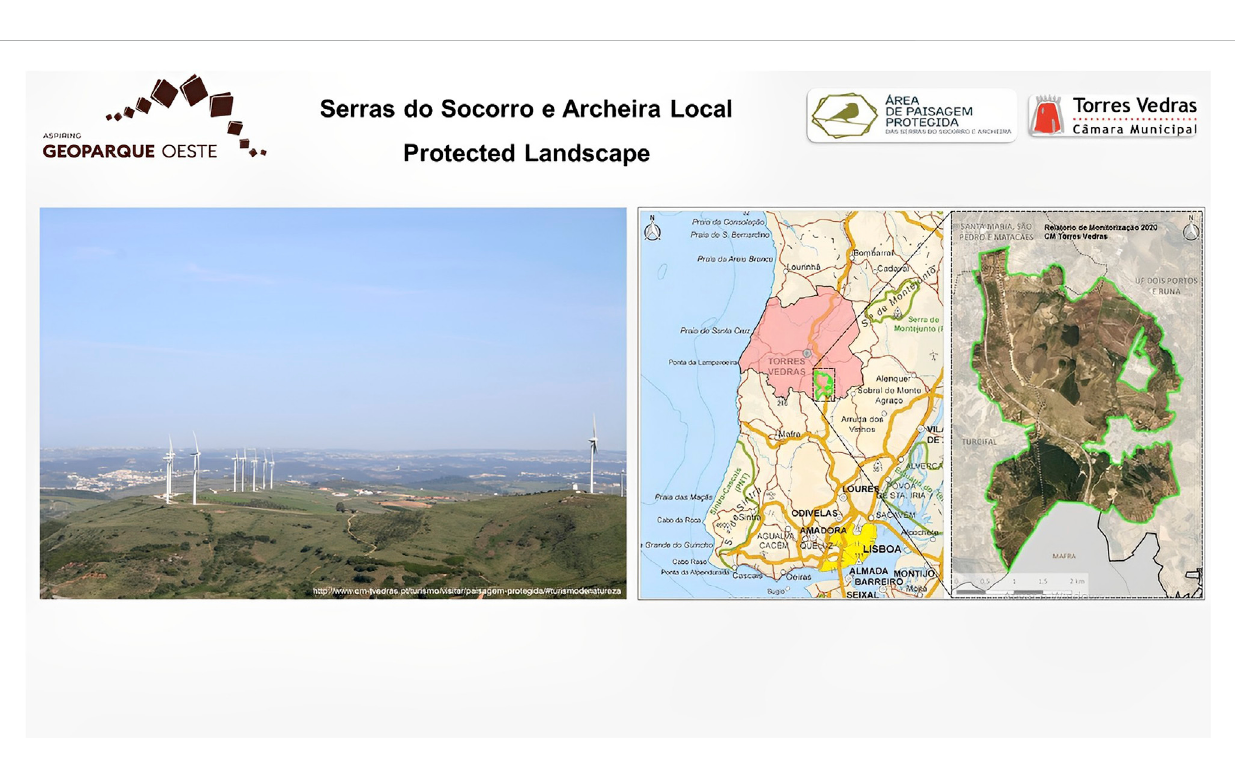
FIGURE 9 Serras do Socorroe e Archeira local protected landscape. Source: produced by the authors.